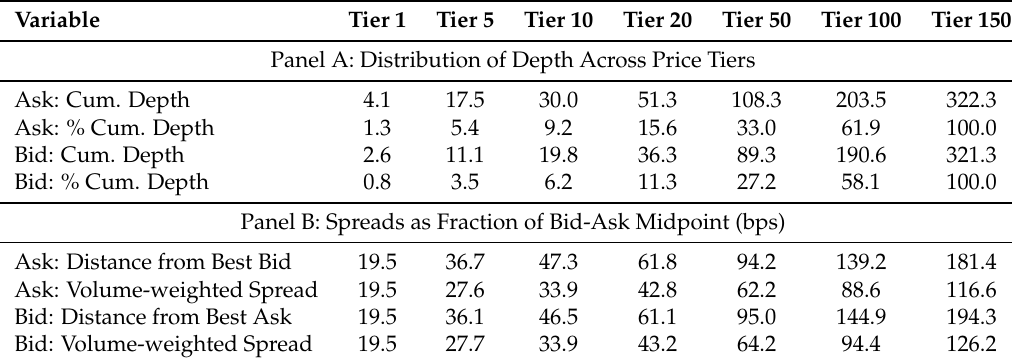
Table 1. Summary statistics of BTC-e limit order book: 7 December 2013 to 24 September